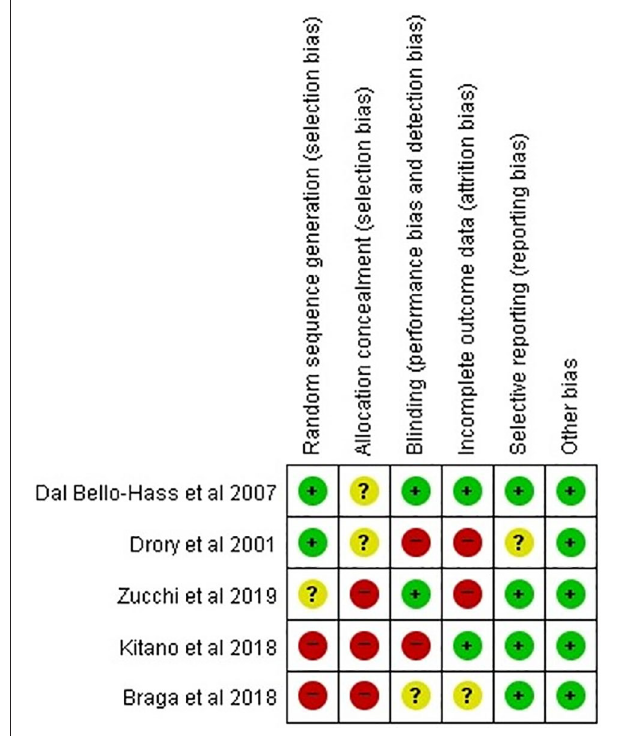
FIGURE 2 | Quality assessment for selected